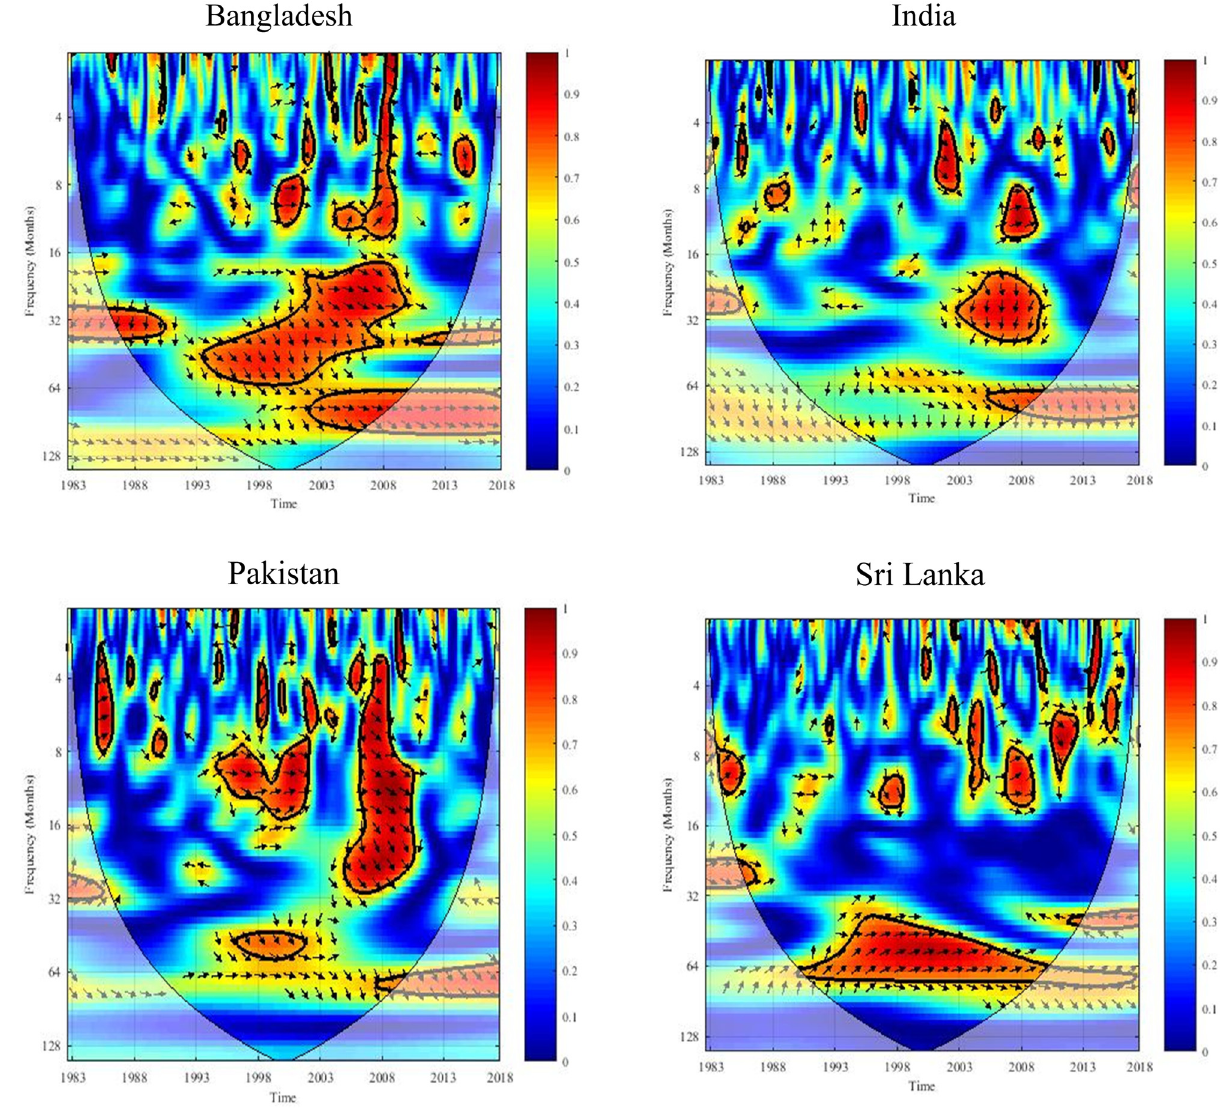
Figure 2: WTC between oil prices and exchange rates. Note: Signi fi cance level at 5% is shown by thick black contour which is calculated using Monte Carlo